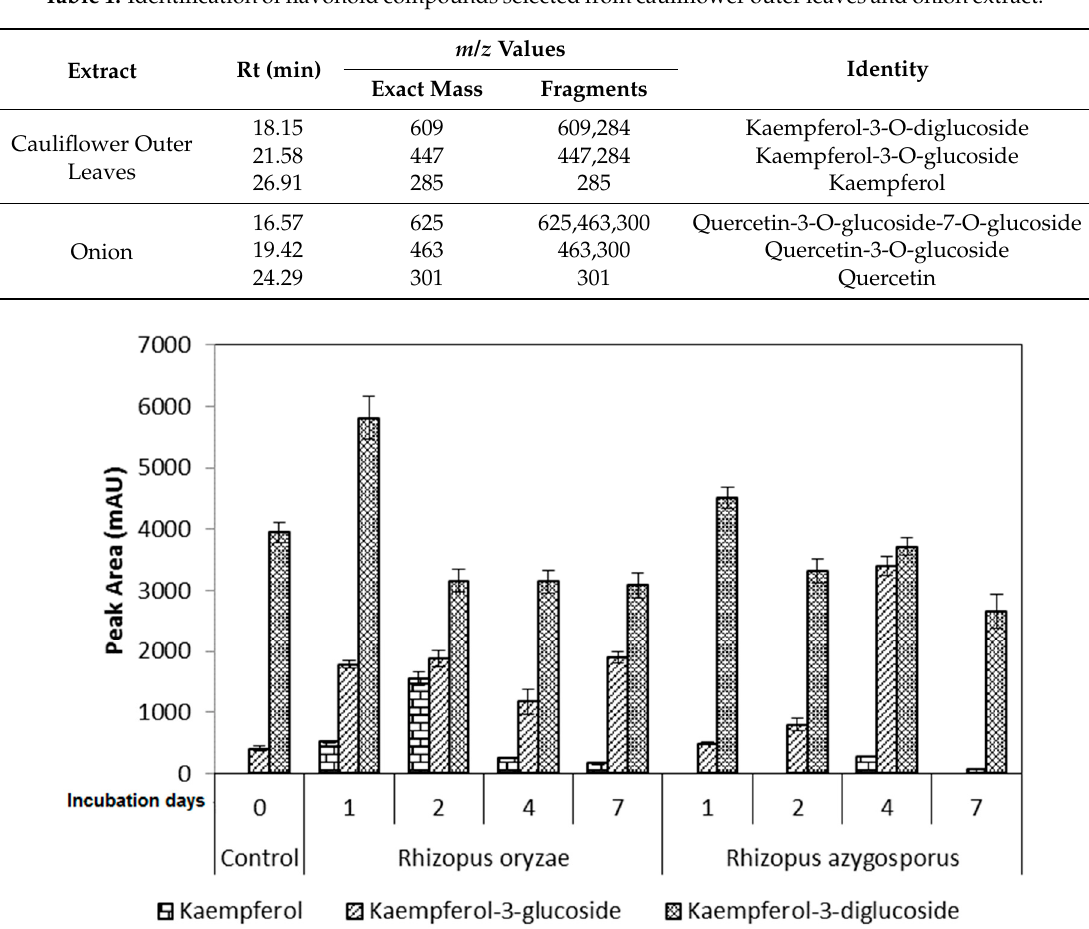
Figure 3. Accumulation of kaempferol, kaempferol-3-O-glucoside, kaempferol-3-diglucoside during 7 days of fermentation of cauliflower outer leave extracts ( n =